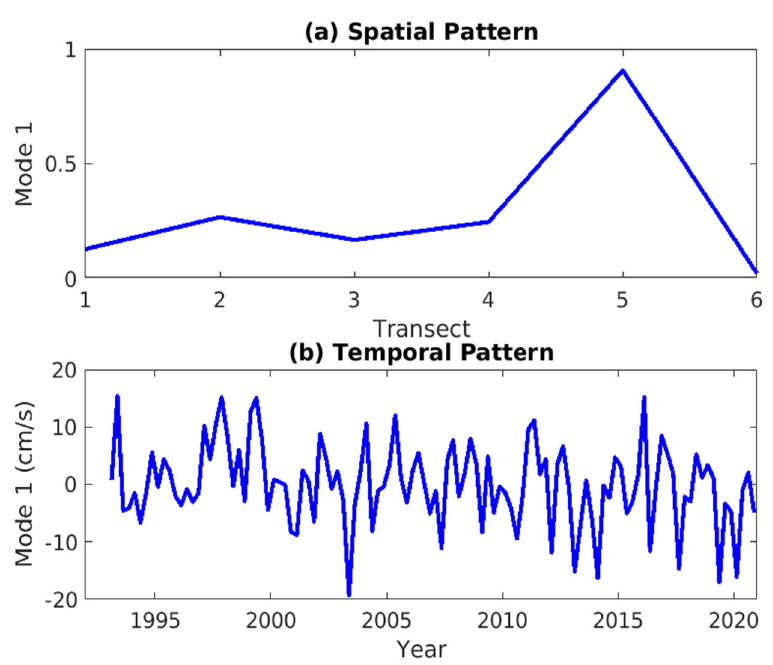
Figure 9. The mode-1 EOF spatial ( a ) and temporal ( b ) patterns of the seasonal longshore current anomalies. Transects 1 to 6 represent the six transects, in the order from the South Vancouver Island Transect to the North Haida Gwaii Transect.